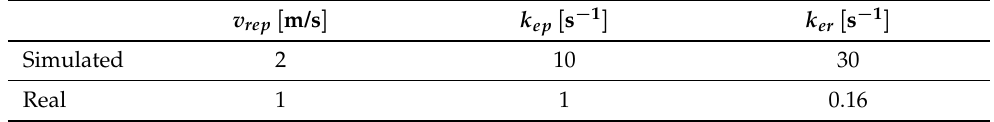
Table 3. Values of the algorithm parameters for the simulation and for the real